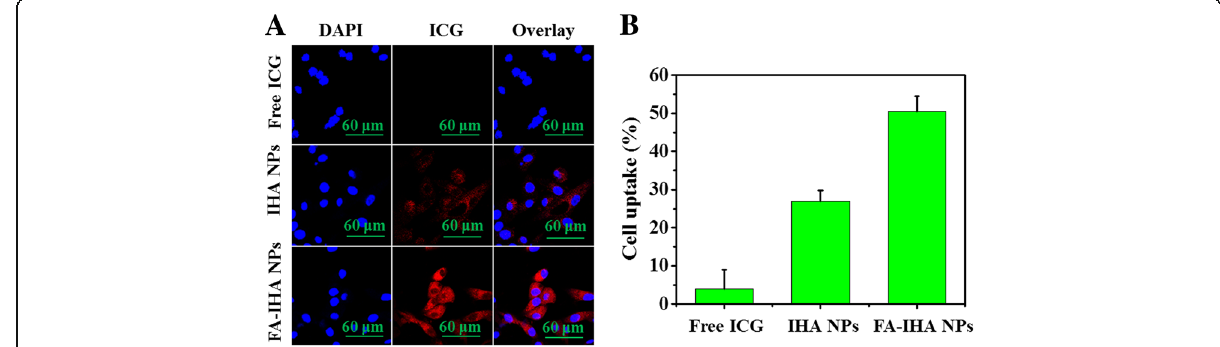
Fig. 5 a Confocal fluorescent images of HepG2 cells after incubation with free ICG and IHA NPs, and FA-IHA NPs. Red and blue colors represent ICG fluorescence and DAPI-stained cell nuclei, respectively. b Flow cytometry measurement of ICG fluorescence intensities in HepG2 cells after incubation with free ICG and IHA NPs and FA-IHA NPs